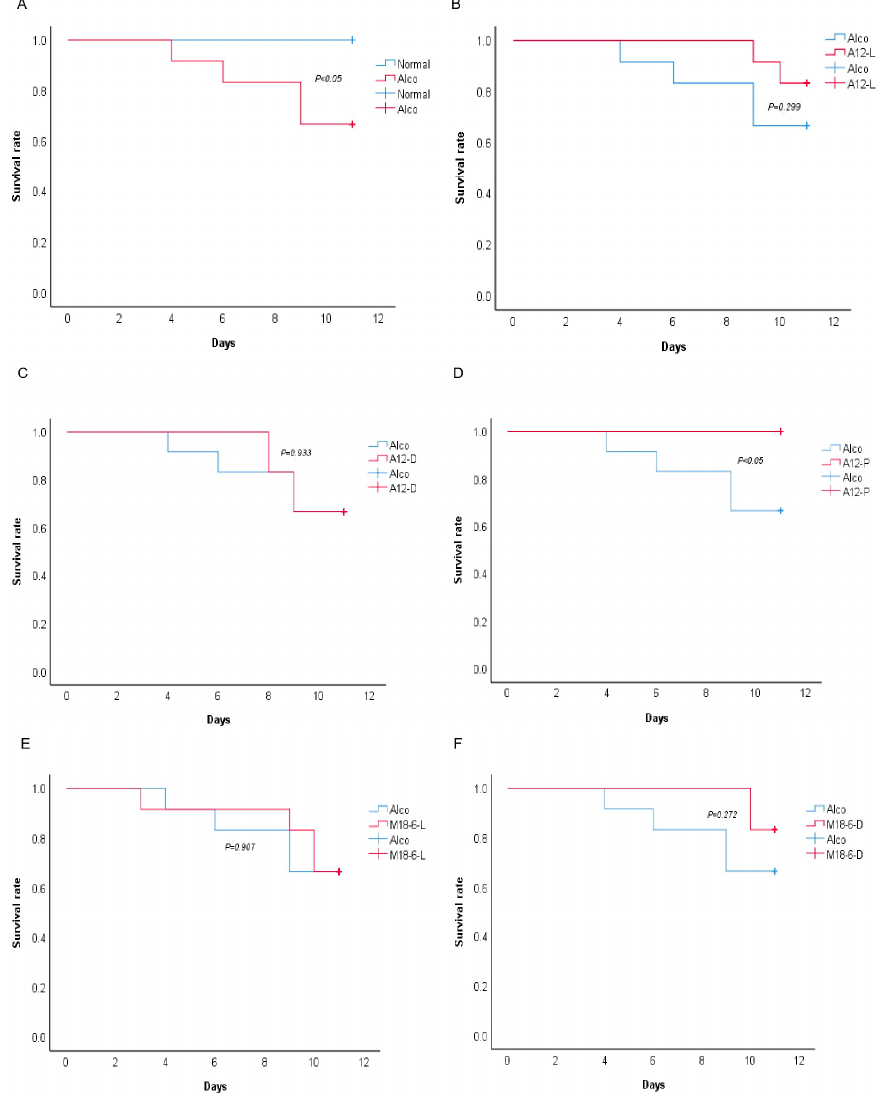
Figure 2. The Kaplan–Meier survival curves in different treated groups. The p -values were calculated using the log-rank test. Each graph shows the comparison of survival rate. ( A ): Between normal and Alco; ( B ): Between Alco and A12-L; ( C ): Between Alco and A12-D; ( D ): Between Alco and A12-P; ( E ): Between Alco and M18-6-L; ( F ): Between Alco and M18-6-D. Normal: normal saline-fed; Alco: alcohol-fed group; A12-L: alcohol-fed with live B. animalis A12 cells group, A12-D: alcohol-fed with dead B. animalis A12 cells group, A12-P: alcohol-fed with B. animalis A12 freeze-dried power group, M18-6-L: alcohol-fed with live L. salivarius M18-6 cells group, and M18-6-D: alcohol-fed with dead L. salivarius M18-6 cells